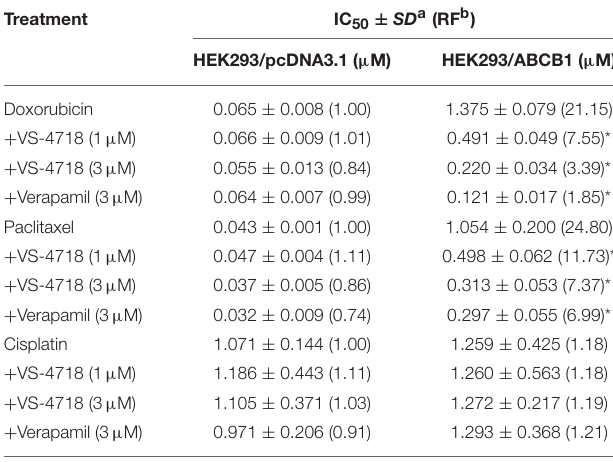
TABLE 2 | VS-4718 sensitized ABCB1-gene-transfected cells to ABCB1 substrates. Treatment